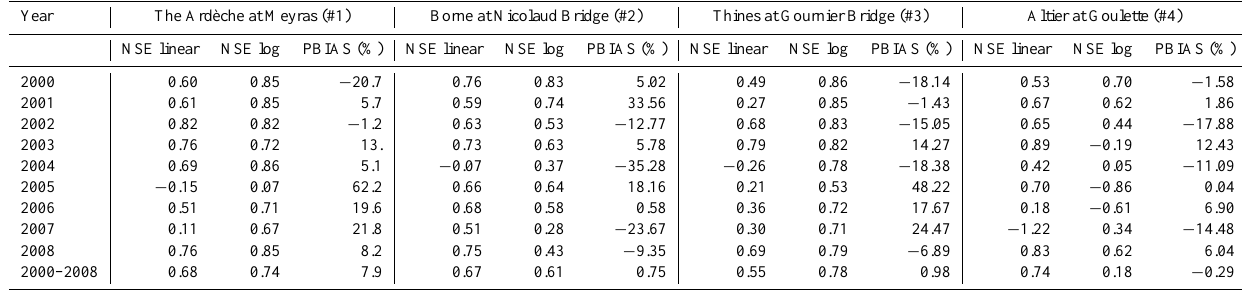
Table 7. Summary statistics of computed NSE, NSE log and PBIAS for each examined catchment in the Ardèche Basin. Year The Ardèche at Meyras (#1) Borne at Nicolaud Bridge (#2) Thines at Gournier Bridge (#3) Altier at Goulette (#4)